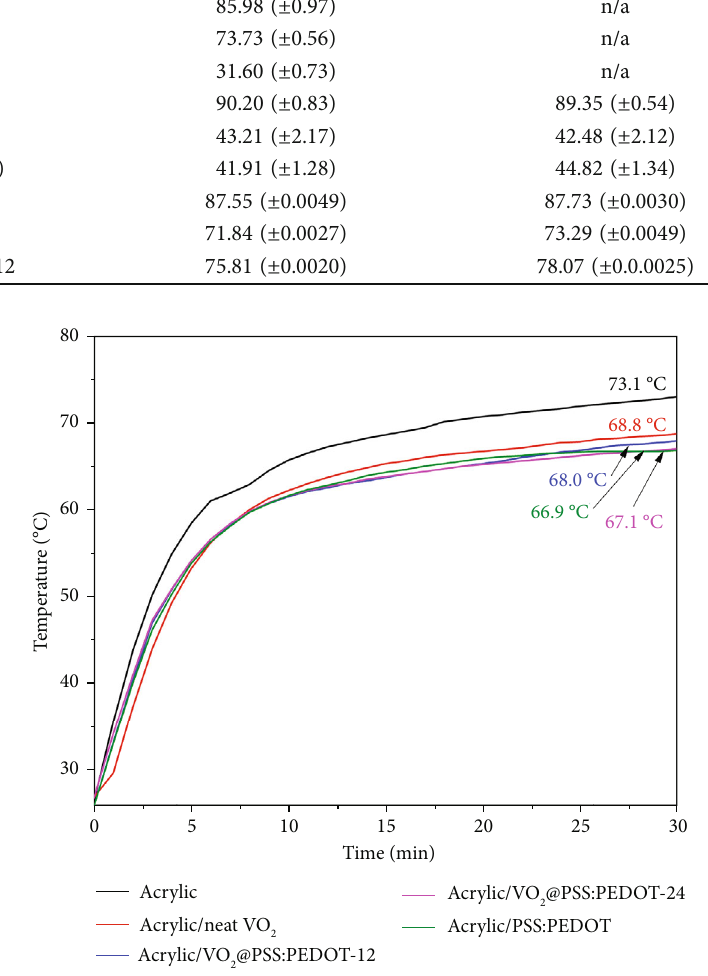
Figure 15: Change in temperature inside the model house installed with glass windows which were coated with various acrylic/VO (1.0 wt%) composite fi lms.